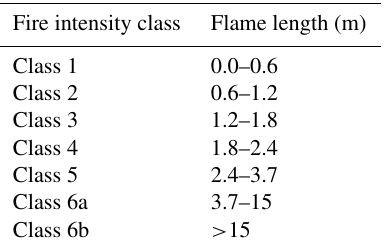
Table 2. Flame length range associated with six standard fire inten- sity classes.